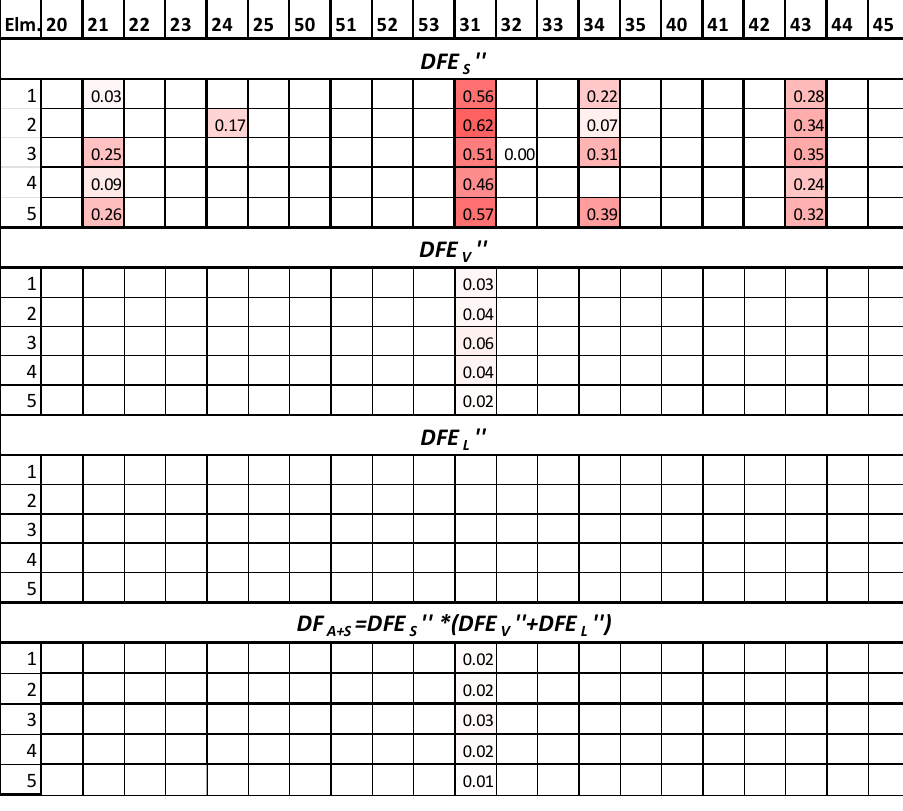
Figure 8. Identified damage using the proposed framework for damage case 1(a).